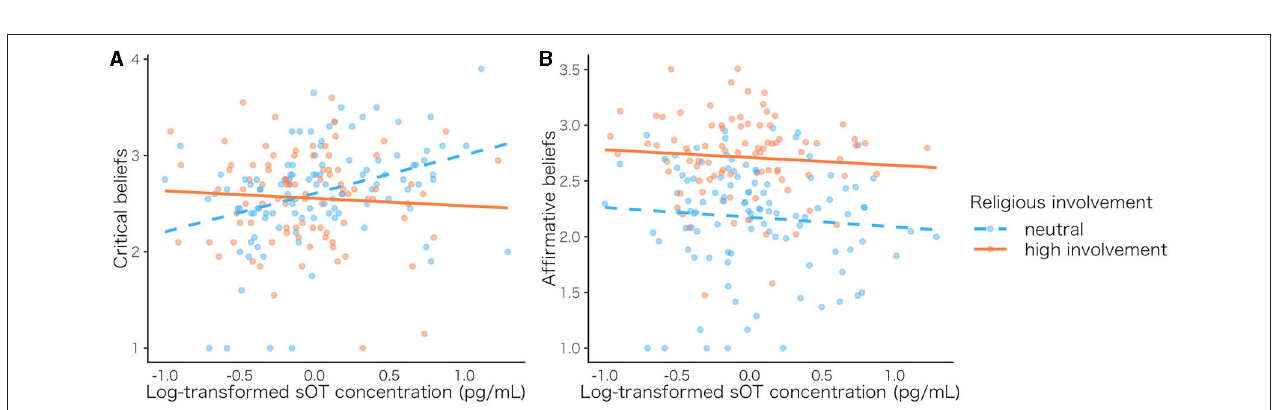
FIGURE 4 | Scatterplots of sOT level and faith for each religious attitude. The orange solid line indicates a positive religious attitude, while the blue dashed line indicates a neutral religious attitude. Relationship between sOT level and critical beliefs (A) , and sOT level and affirmative beliefs (B) . sOT, salivary